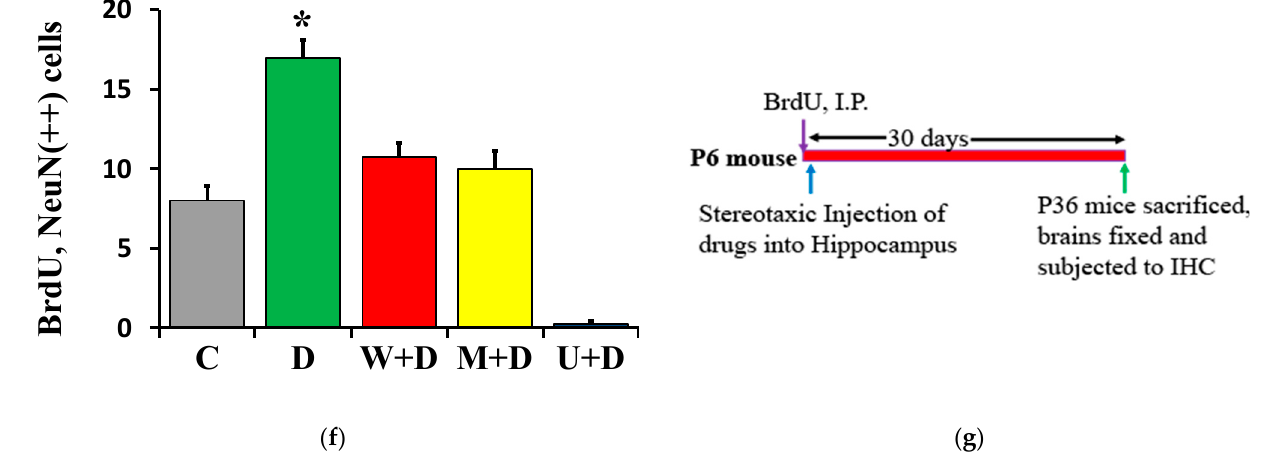
Figure 5. Activated 5-HT 1A -R evokes PKC ε and ERK1/2-mediated neurogenesis in P6 DG. After BrdU treatment (i.p.), one set of five pups in each experiment was dedicated to fluoxetine (Flx) infusion alone (Figure S2). Two such experiments were conducted to obtain the results presented here. Thirty days after treatment and intrahippocampal infusion of D in the absence or presence of inhibitors, the brains were processed for immunohistochemistry (IHC). ( a – f ) Co-localization of BrdU (red) with NeuN (green) in cells (shown using white arrows) indicated increased neurogenesis with D, which was eliminated in the presence of antagonist (W) ( c ), M ( d ), and U ( e ). Lower panels: red BrdU (+) cells shown by blocking the green and blue channels. ( f ) Mean BrdU, NeuN (++) cell number in the DG per hippocampal section calculated from nine sections per mouse and four or five mouse pups per treatment showed that the D group harbored significantly higher BrdU, NeuN (++) cells than all other groups (see Results for details and Figure S2 for the Flx set). (One-way ANOVA: F(5,21) = 36.47, p < 0.0001) and post-hoc tests showed that the D group was significantly higher ( p < 0.05) than the inhibitor-treated groups. ( g ) Treatment strategy and time line. Scale bar: 75 µm. * p < 0.05.